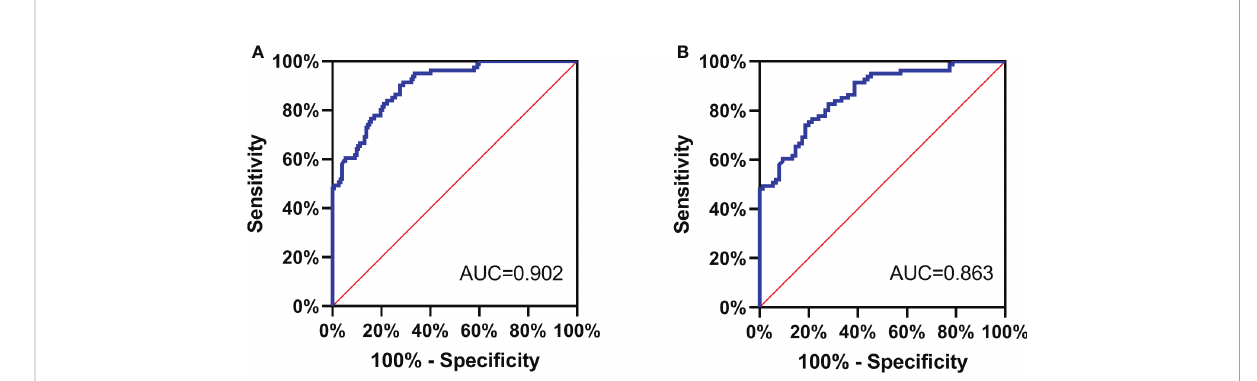
FIGURE 2 (A) All the subjects were divided into PTC group and non-PTC group. The serum NDRG3 was used as a test variable, and the group non-PTC as the state variable to plot the ROC curve; (B) In the PTC and BTN groups, serum NDRG3 was used as the test variable and BTN as the state variable, so as to plot the ROC